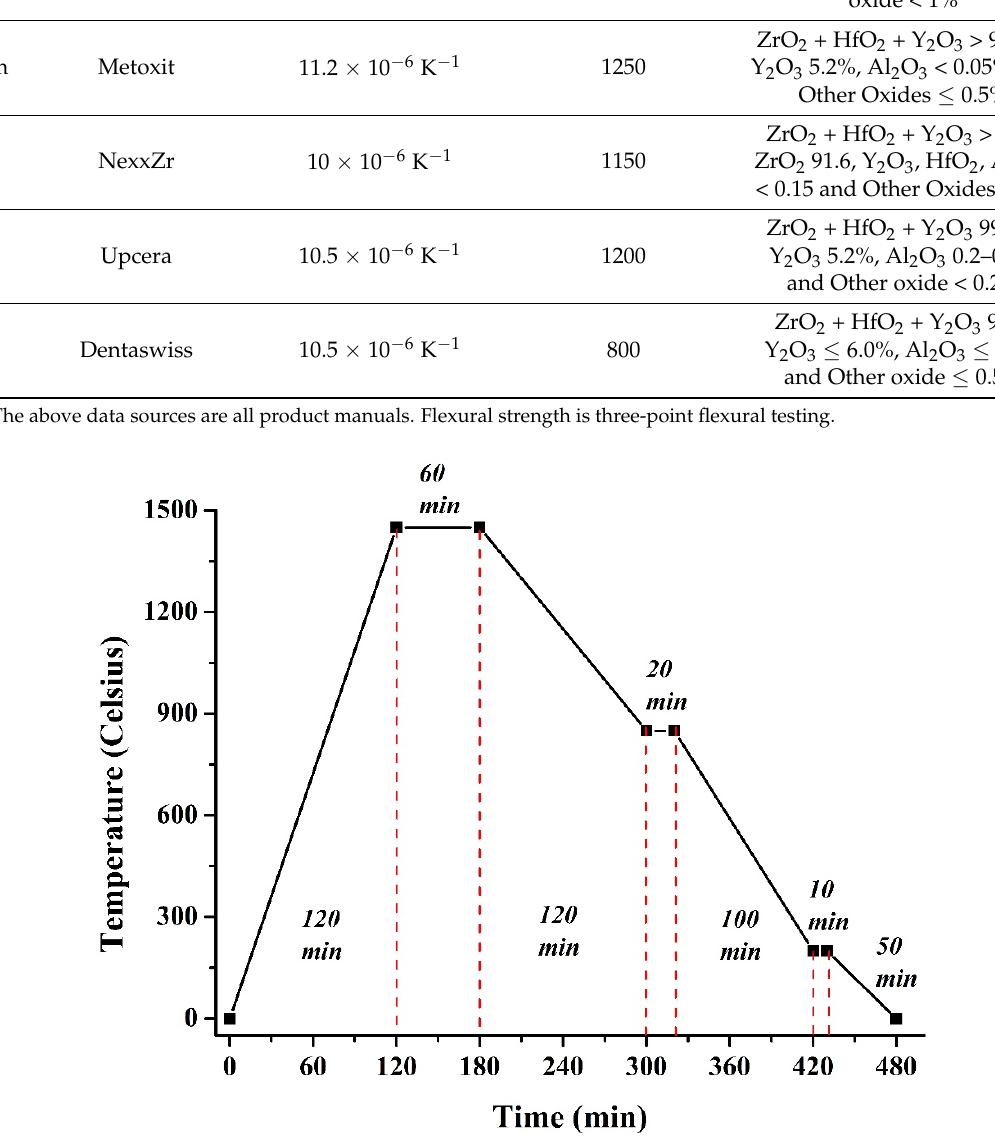
Figure 1. Zirconia sample sintering schedule.